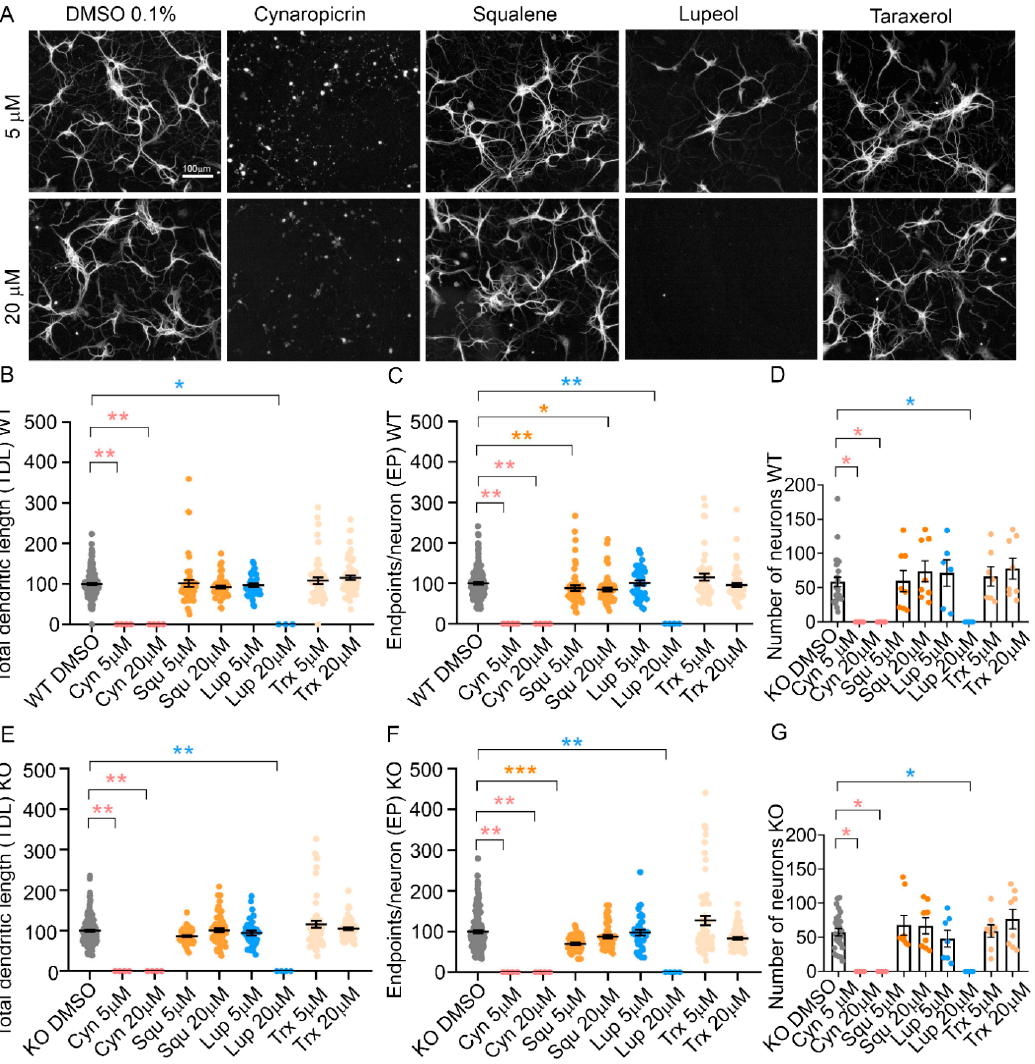
Figure 6. Treatments of neuronal cultures with bioactive molecules. ( A ) NeuriteQuant morphological analysis of TDL and Endpoints of WT hippocampal neurons at DIV 6 (n = 4). From left, WT neurons treated with DMSO 0.1% (control condition), cynaropicrin, squalene, lupeol, taraxerol. First line represents neurons treated at the concentration of 5 µM (in DMSO 0.1%), second line at 20 µM (in DMSO 0.1%). Scale bar: 100µm. ( B , C ) Quantitative data of WT neurons, reporting the average TDL per neuron (µm) and the average number of endpoints per WT neuron n= 44 images for a total of 4 independent biological replicates (cell cultures). ( D ) Number of WT neurons per each condition. ( E , F ) Quantitative data of MeCP2 KO neurons, reporting the average TDL per neuron (µm) and the average number of endpoints per neuron. n= 44 images for a total of 4 independent biological replicates (cell cultures). ( G ) Number of MeCP2 KO neurons per each condition. Kruskal–Wallis with Dunnett’s multiple comparisons test vs DMSO conditions. *** p < 0.001, ** p < 0.01, * p < 0.05.